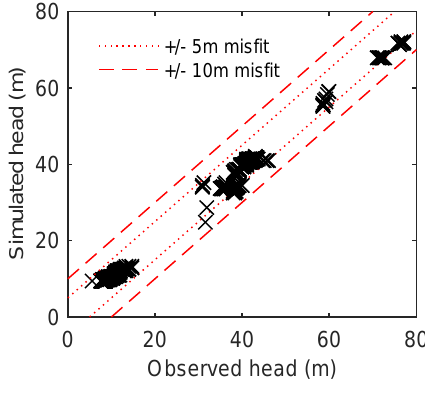
Figure 11. Scatter plot of observed and simulated heads values from the 1995–1999 validation period. Dashed lines mark misfits larger than 10m and dotted lines mark misfits larger than